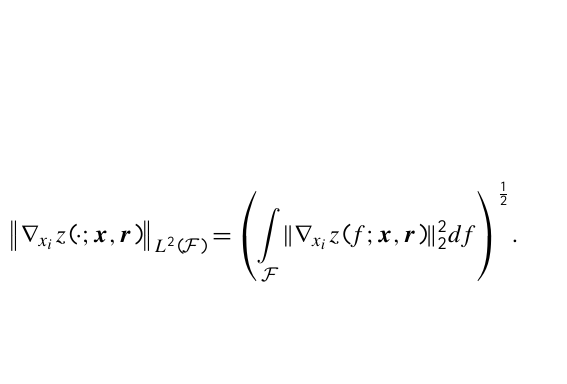
Figure 4. Sensitivity of the impedance for the geometry of the ring electrodes shown in Fig. 8 to various material parameters against frequency w.r.t. (a) c 44 , (b) e 15 , and (c) ε 11 .